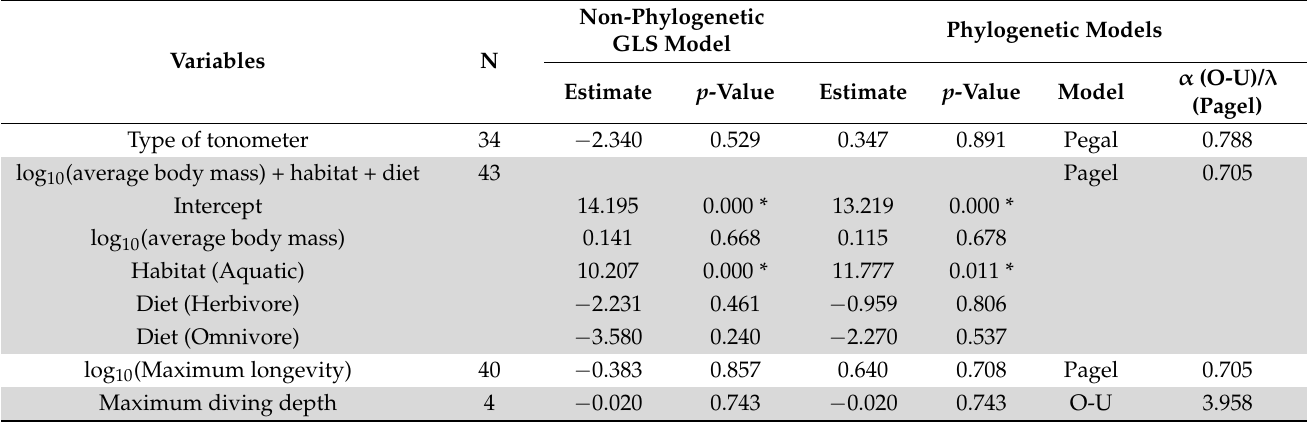
Table 3. Results of generalized least squares, with and without phylogenetic models, for life history traits in birds. Asterisks represent significant results. For the habitat variable, terrestrial is the reference level. For the diet variable, carnivore is the reference